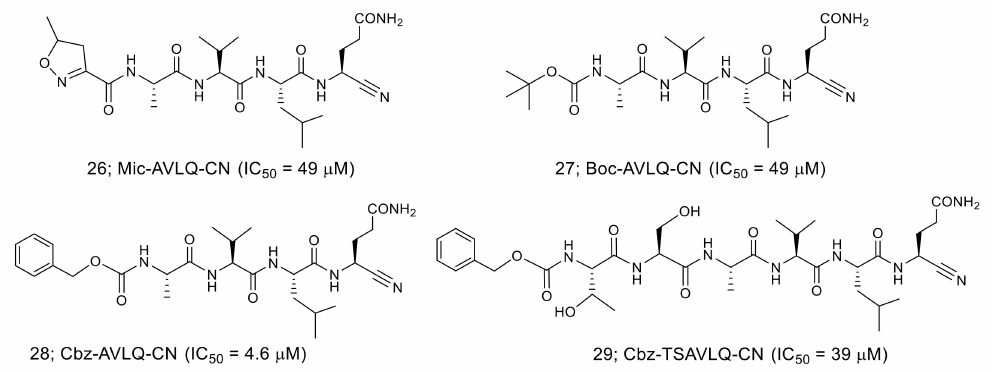
Figure 7. Structures and IC 50 values of the nitrile-based inhibitors against SARS-CoV 3CL pro